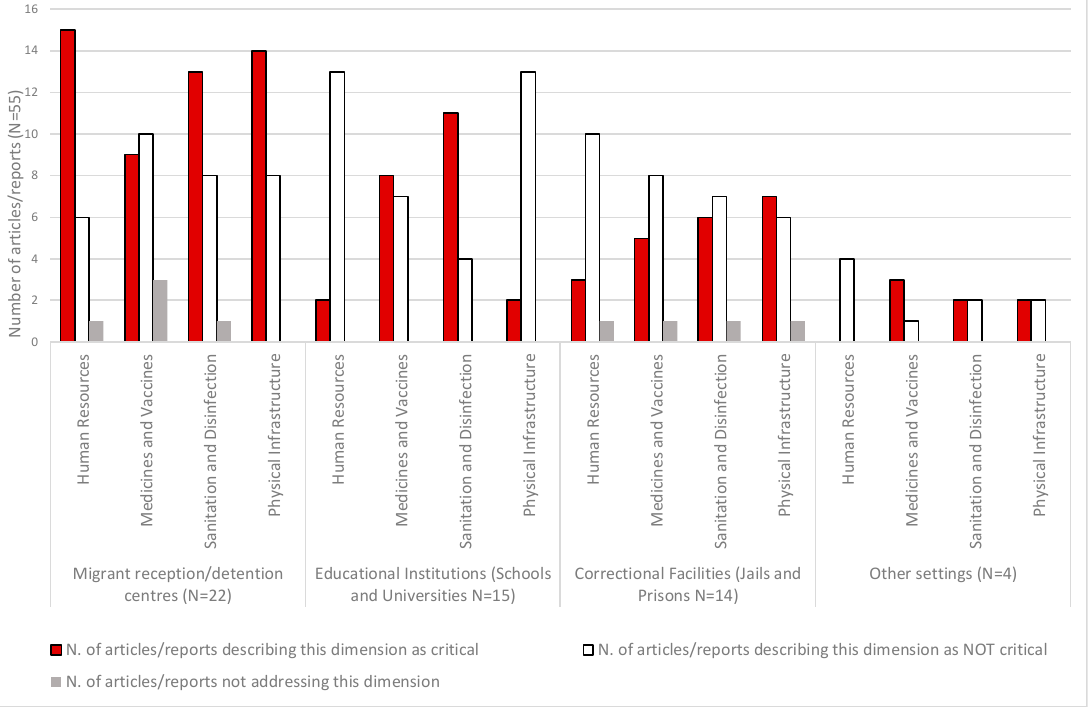
Figure 4. Number of articles or reports addressing the first review objective ( n = 55), by dimension and institutional setting.